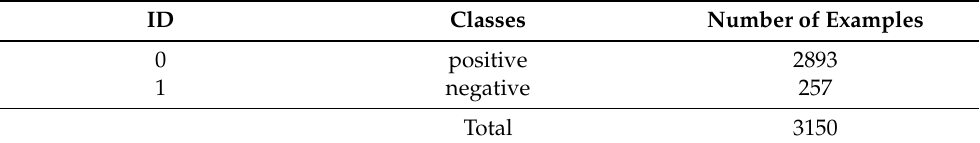
Table 5. Amazon Alexa Reviews dataset.